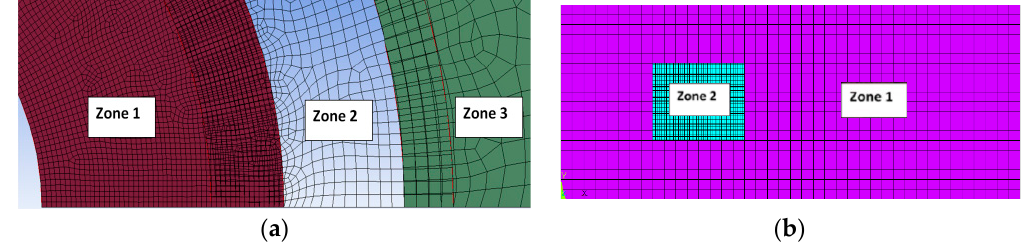
Figure 5. Zonal concepts for ( a ) partial and ( b ) full overlapping grids.